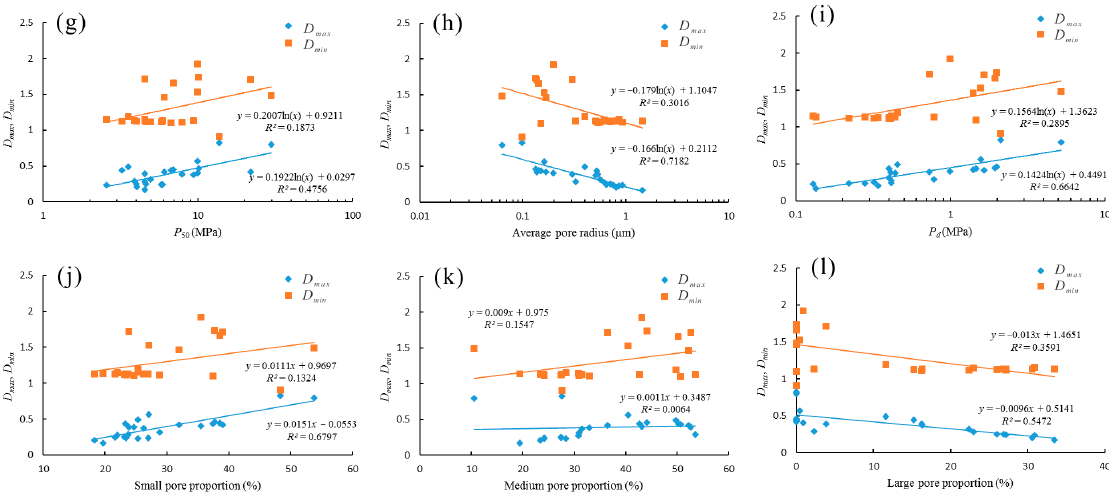
Figure 10. The cross plots between multifractal parameters and MICP parameters. ( a ) the cross plots between α max , α min and P 50 ; ( b ) the cross plots between α max , α min and average pore radius; ( c ) the cross plots between α max , α min and P d ; ( d ) the cross plots between α max , α min and small pore proportion; ( e ) the cross plots between α max , α min and medium pore proportion; ( f ) the cross plots between α max , α min and large pore proportion; ( g ) the cross plots between D max , D min and P 50 ; ( h ) the cross plots between D max , D min and average pore radius; ( i ) the cross plots between D max , D min and P d ; ( j ) the cross plots between D max , D min and small pore proportion; ( k ) the cross plots between D max , D min and medium pore proportion; ( l ) the cross plots between D max , D min and large pore proportion.